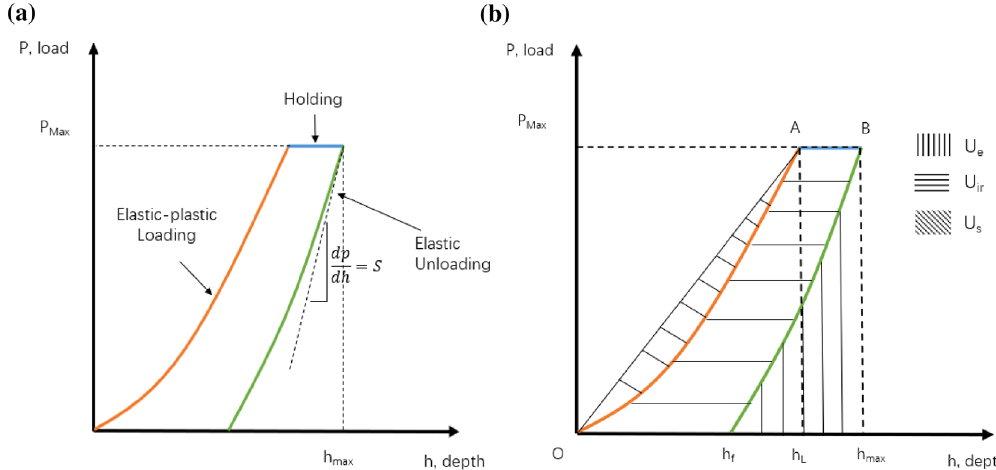
Figure 7. ( a ) Typical load-displacement curve obtained from nanoindentation test. This curve highlights three distinct regions of: loading, holding, and unloading. ( b ) Typical load-displacement curve obtained from nanoindentation highlighting different areas associated with elastic, irreversible, and absolute energy 14